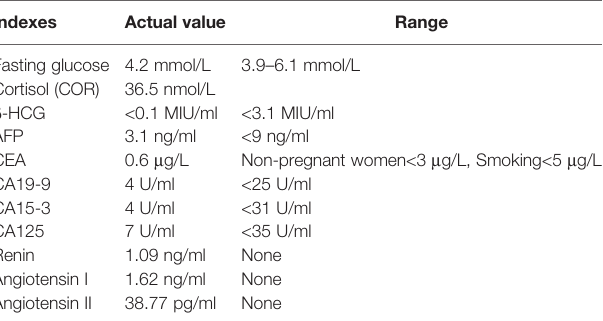
TABLE 1 | Detection of adrenal gland related